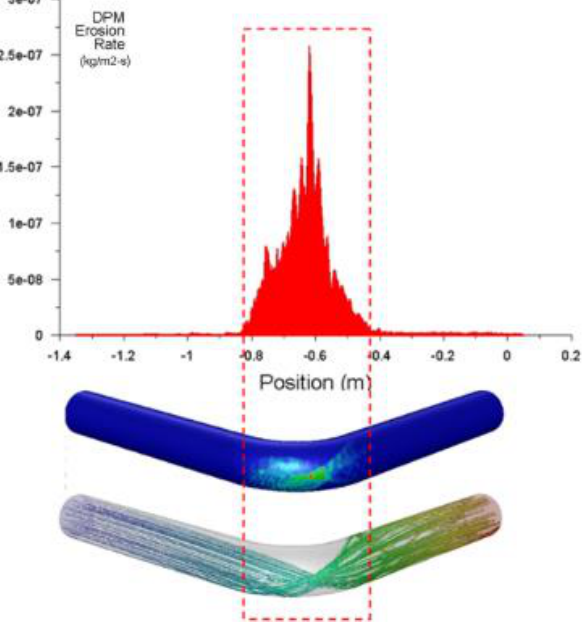
Figure 7. Erosion rate distribution and particle trajectories in the elbow.